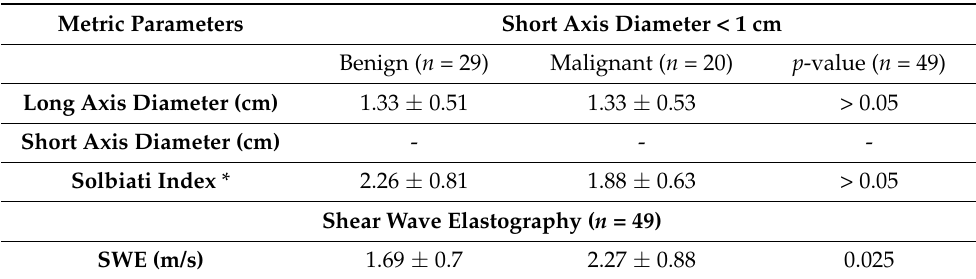
Table 4. Analysis of subgroup “Short axis diameter < 1 cm”. All metric variables are given as mean with corresponding standard deviation. Abbreviations: SWE, shear wave